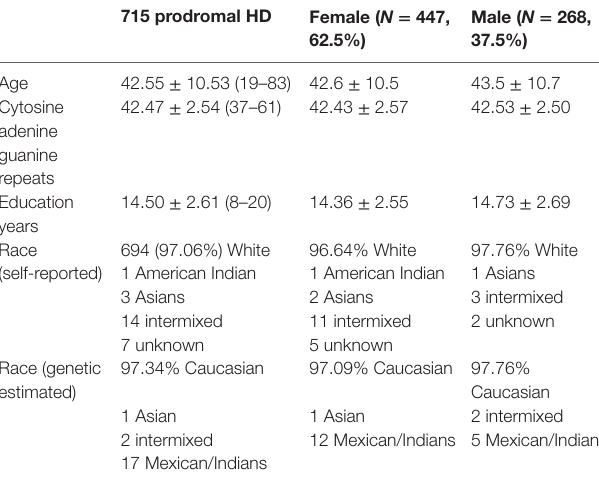
TaBle 1 | Demographic information of